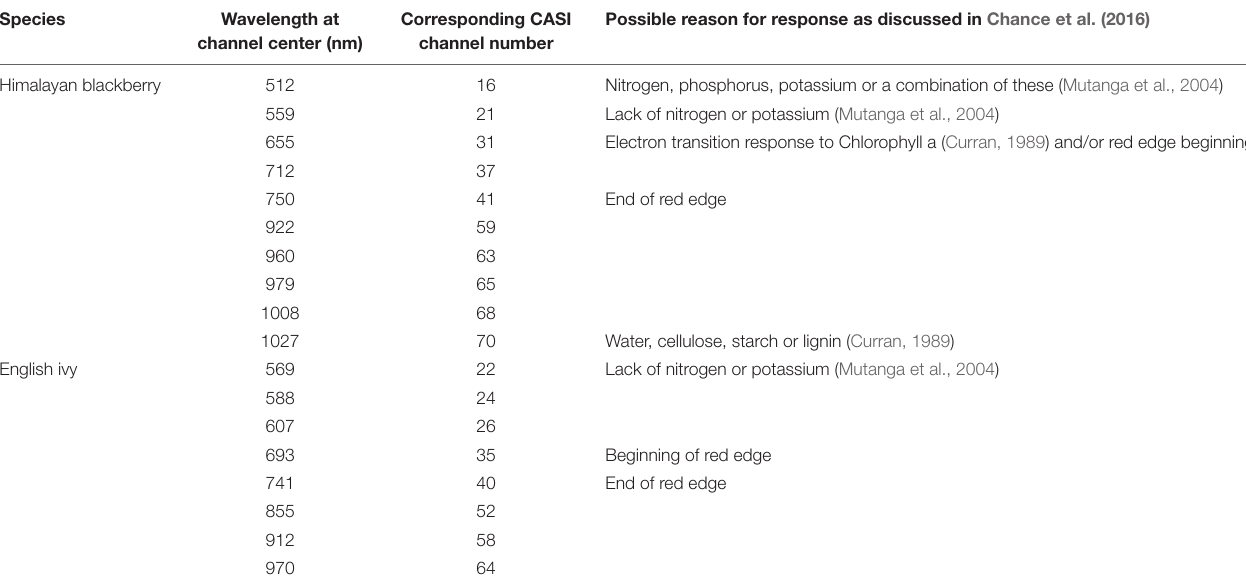
TABLE 2 | Key CASI (Compact Airborne Spectrographic Imagery) spectral channels and their corresponding wavelengths for differentiating Himalayan blackberry ( Rubus armeniacus ) and English ivy ( Hedera helix ) from each other and other common species in Surrey, BC, Canada, and the possible causes of the responses shown at these wavelengths and discussed in Chance et al.